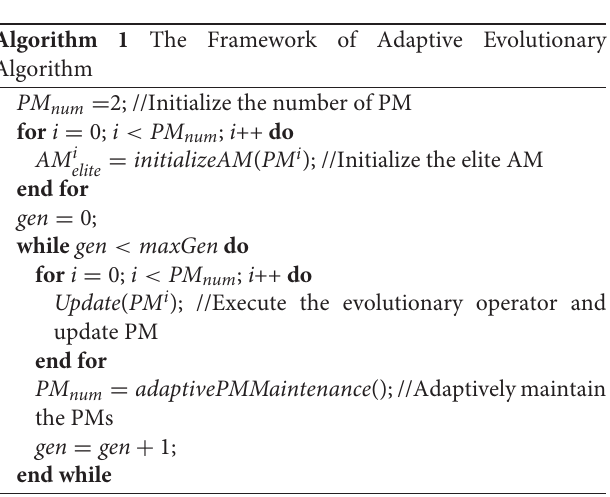
Algorithm 1 The Framework of Adaptive Evolutionary